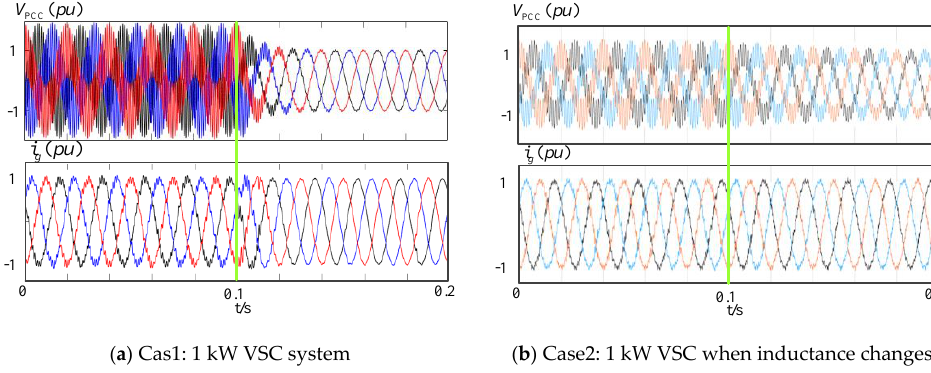
Figure 4. High frequency resonance (HFR) damping control based on wideband virtual impedance for VSC systems.